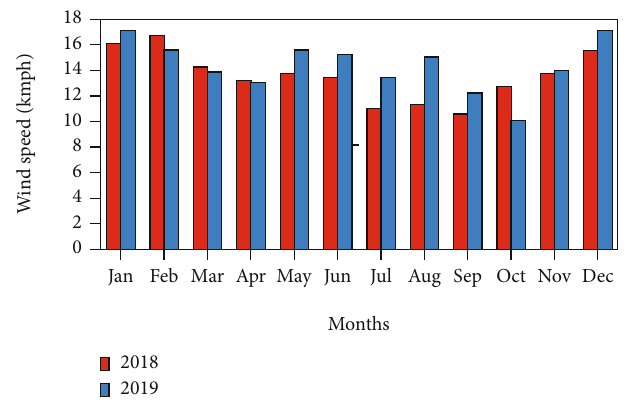
Figure 5: Average wind speed of ACGCET campuses.